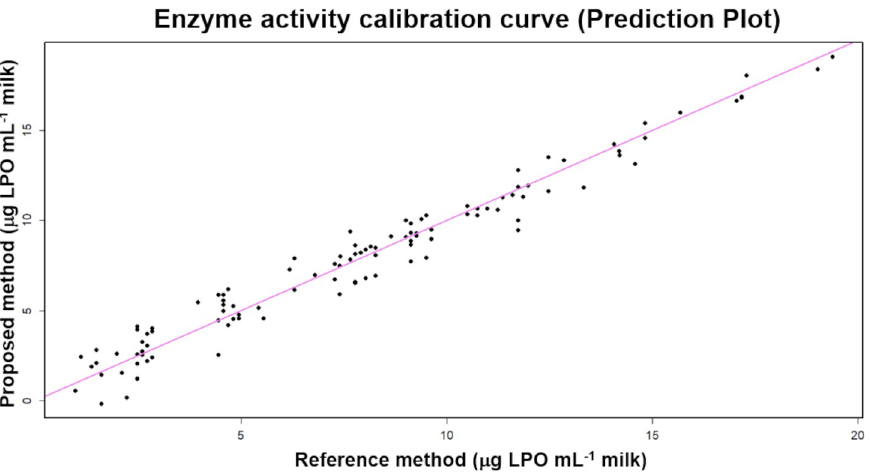
Fig 5. Enzyme activity calibration curve. Lactoperoxidase analysis showing the predicted activity (y-axis) vs measured activity (x-axis) and the correlation between the proposed method for quantifying lactoperoxidase and the reference method. Adjusted R 2 = 0.96 by multiple linear